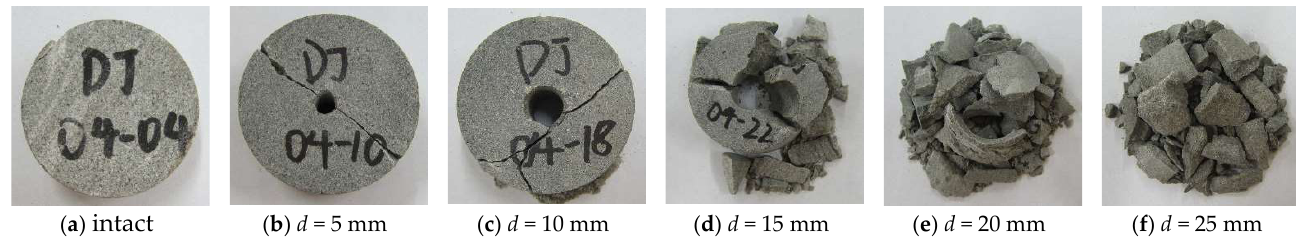
Figure 15. Fracture morphology of specimens without temperature and water coupling.